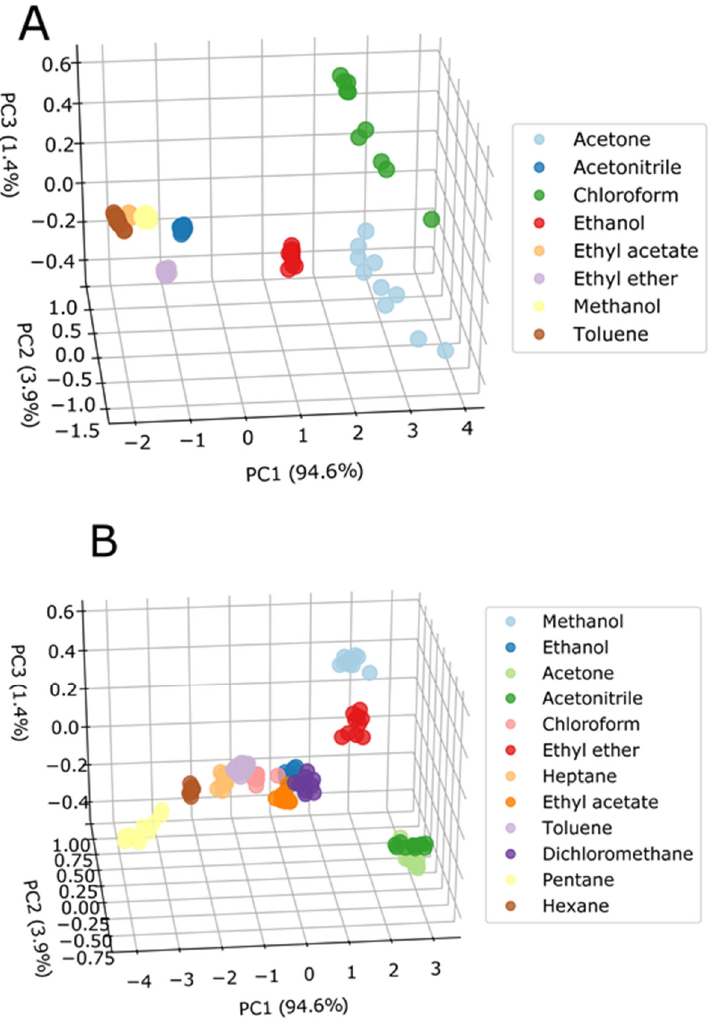
Figure 7. PCA scatter plots indicating the variance of each component (in brackets) for the VOCs tested (PC = principal component); ( A ) with set A sensors and ( B ) with set B sensors. As mentioned earlier, the PCA generates orthogonal vectors from the input